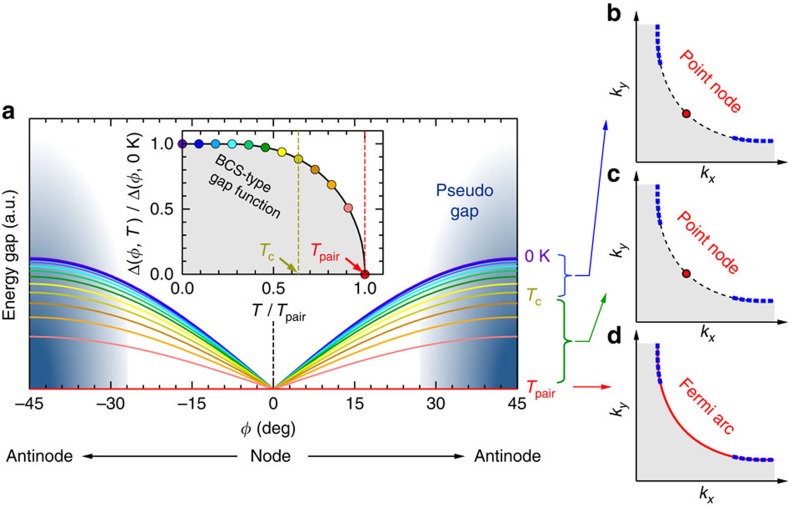
Schematic pairing gap evolution based on our ARPES results.(a) Temperature variation of the point nodal d-wave pairing gap. The energy gap has a BCS-type function (inset curve) with the same onset at Tpair regardless of directions (φ) along the Fermi surface. Temperatures for each curve are indicated in the inset with coloured circles. The gapped Fermi surface with a point node below Tc (b) persists beyond Tc (c) up to the temperature of pair formation (Tpair). (d) Emergence of the gapless Fermi arc centered at the node due to the pseudogap evolution around the antinode927; while the antinodal region is not observable at the low photon energies like 7 eV, the studies with higher energy photons have demonstrated that the competing pseudogap state emerges at |φ|>25° in the optimal doping9.